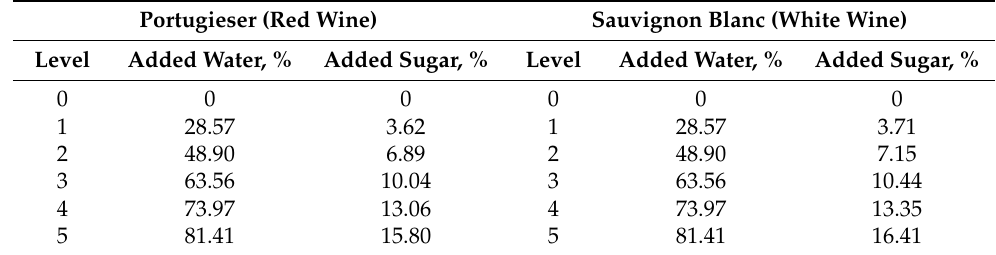
Table 1. Wine adulteration levels of water dilution ( v / v ) or added sugar ( m / m ). Portugieser (Red Wine)